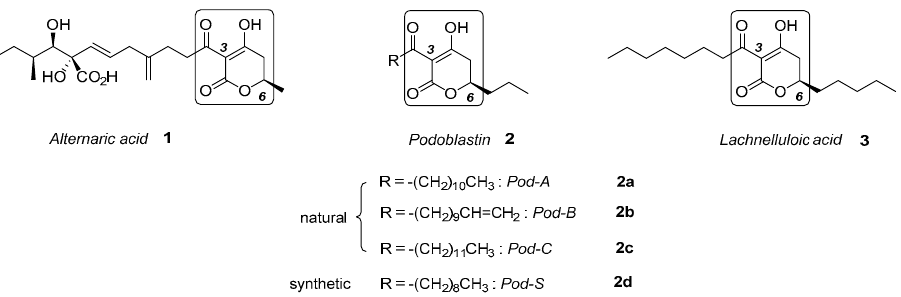
Figure 1. Representative natural products ( 1 , 2a – c , 3 ) and a synthetic analogue ( 2d ) containing the 3-acyl-5,6-dihydro-2 H -pyran-2-one structure.